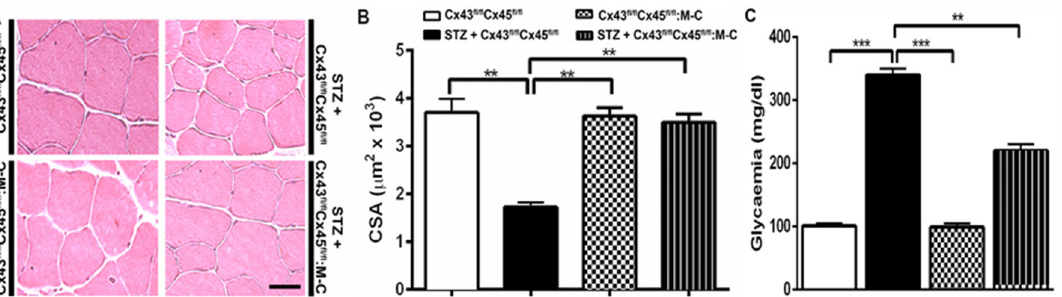
Figure 5. Deletion of Cx43 and Cx45 prevents skeletal muscle atrophy and partially prevents the glycaemia elevation induced by STZ in mice. ( A ) Representative hematoxylin–eosin-stained preparations of TA muscles from control (Cx43 fl/fl Cx45 fl/fl ), control treated with STZ (STZ + Cx43 fl/fl Cx45 fl/fl ), Cx43/Cx45 muscle-expression-deficient mice (Cx43 fl/fl Cx45 fl/fl : M-C), and Cx43 fl/fl Cx45 fl/fl : M-C + STZ mice. ( B ) Quantification of all sets of images collected as shown in ( A ). ( C ) Glycaemia levels were analyzed from tail blood of Cx43 fl/fl Cx45 fl/fl ; STZ + Cx43 fl/fl Cx45 fl/fl mice treated or not with boldine. The cross-sectional area (CSA) was evaluated to analyze the presence of atrophy. Control animals of the same age were used as controls (N = 5 animals; each value corresponds to the average ± SEM, ** p < 0.01 and *** p < 0.001. Scale bar: 50 µ m.